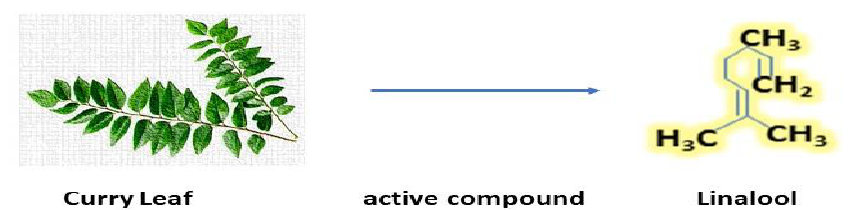
Figure 5. Most active compound of curry leaf (Linalool).